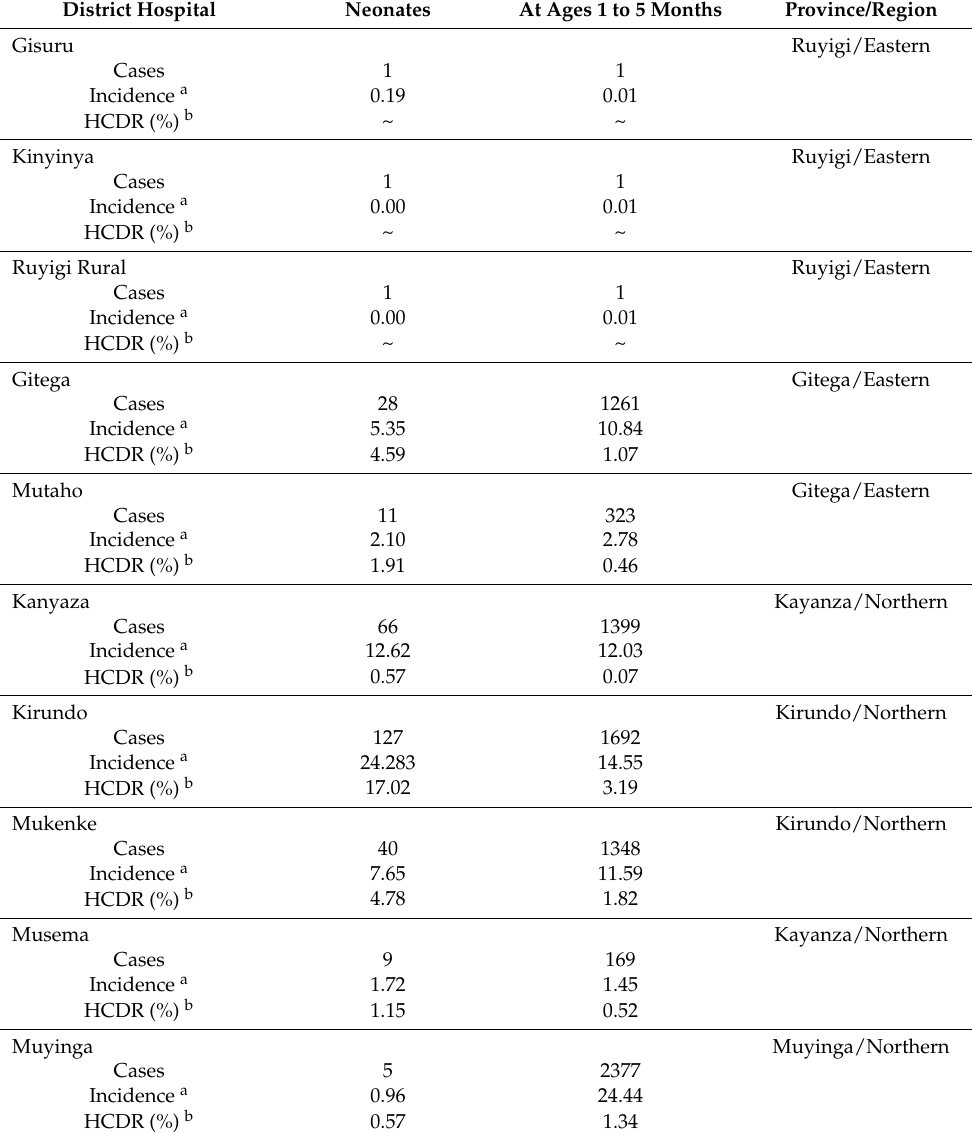
Table 3. All causes of hospitalization and death rates by age, region and province,